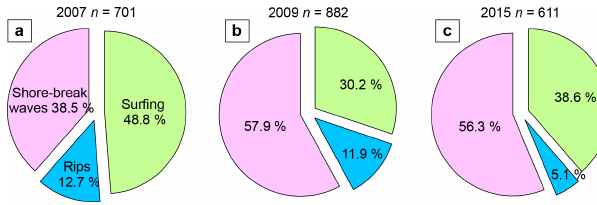
Figure 14. Percentage of SZIs by year: (a) 2007 with tan β ≈ 0 . 06 and deep rip channels, (b) 2009 with tan β ≈ 0 . 16 and deep rip channels, and (c) 2015 with tan β ≈ 0 . 16 and subtle rip channels.